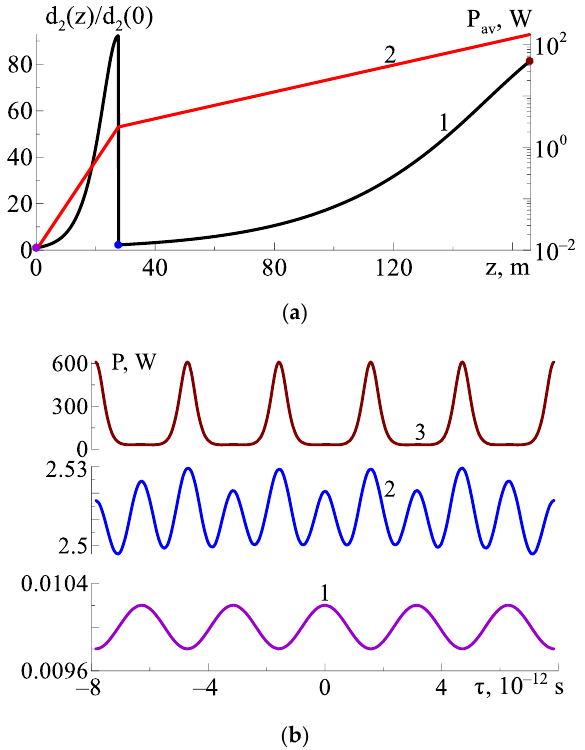
Figure 3. Evolution of the input optical signal in Equation (22) to the picosecond pulse train in the fiber cascade comprising two fibers with the GVD profile in Equation (17). ( a ) The GVD distribution along the fiber length (curve 1); the pulse peak power as a function of the fiber length (curve 2); ( b ) the optical signals at the first fiber segment input (curve 1), at the second fiber segment input (curve 2), and at the second fiber segment output (curve 3). The violet, blue and brown points on the curve 1 at ( a ) correspond to curves of the same colors in ( b ).